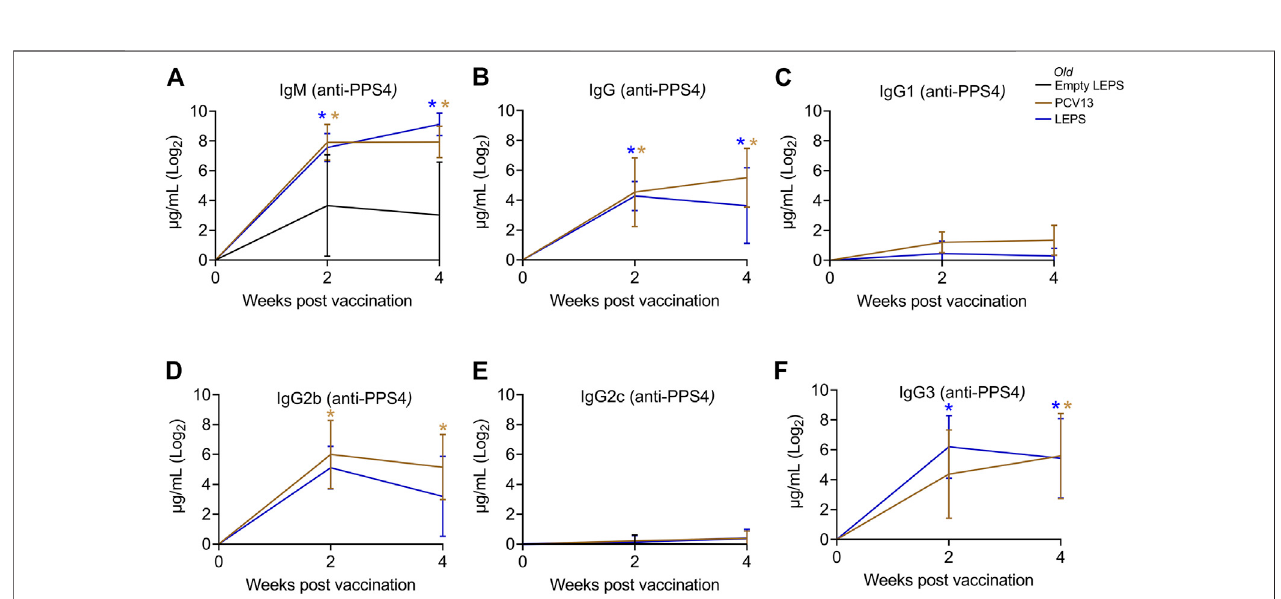
FIGURE 3 | The LEPS vaccine and Prevnar-13 induce comparable levels of antibodies against pneumococcal polysaccharide in old hosts. Old C57BL/6 mice (18 – 22 months)wereinjected i.m. withLEPScontainingserotype4capsularpolysaccharideantigen,PCV13, orthecontrols(Sham orEmptyLEPSvector) followingthe timelinein Figure1B .TotallevelsofIgM (A) ,IgG (B) ,and IgGsubtypes includingIgG1 (C) ,IgG2b (D) ,IgG2c (E) andIgG3 (F) againstpuri fi edpolysaccharideserotype4 in the sera were measured over time by ELISA. p values were determined by one-way ANOVA followed by Tukey ’ s test. Asterisks (* p < 0.05) indicate signi fi cant differences between the indicated group and the empty LEPS group. Data shown are presented as mean ± CI and are pooled from 3 separate experiments with n (cid:2) 5 mice for Empty LEPS, n (cid:2) 10 mice for LEPS, and n (cid:2) 10 mice for the PCV13 groups.